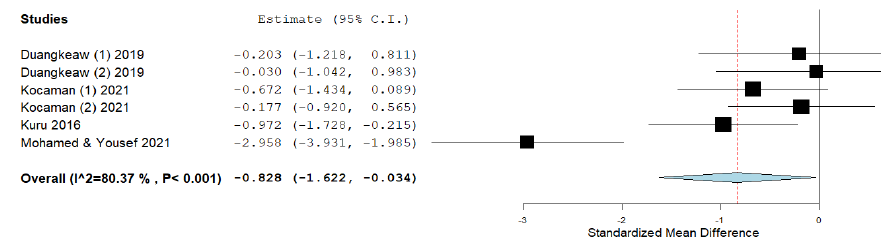
Figure 6. Effect size for the outcome ATR.